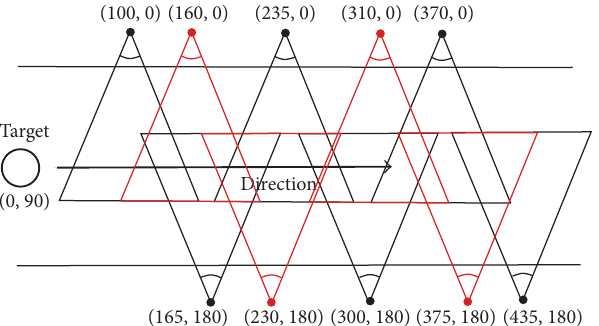
Figure 14: Monitoring scenario with the addition of four new visual